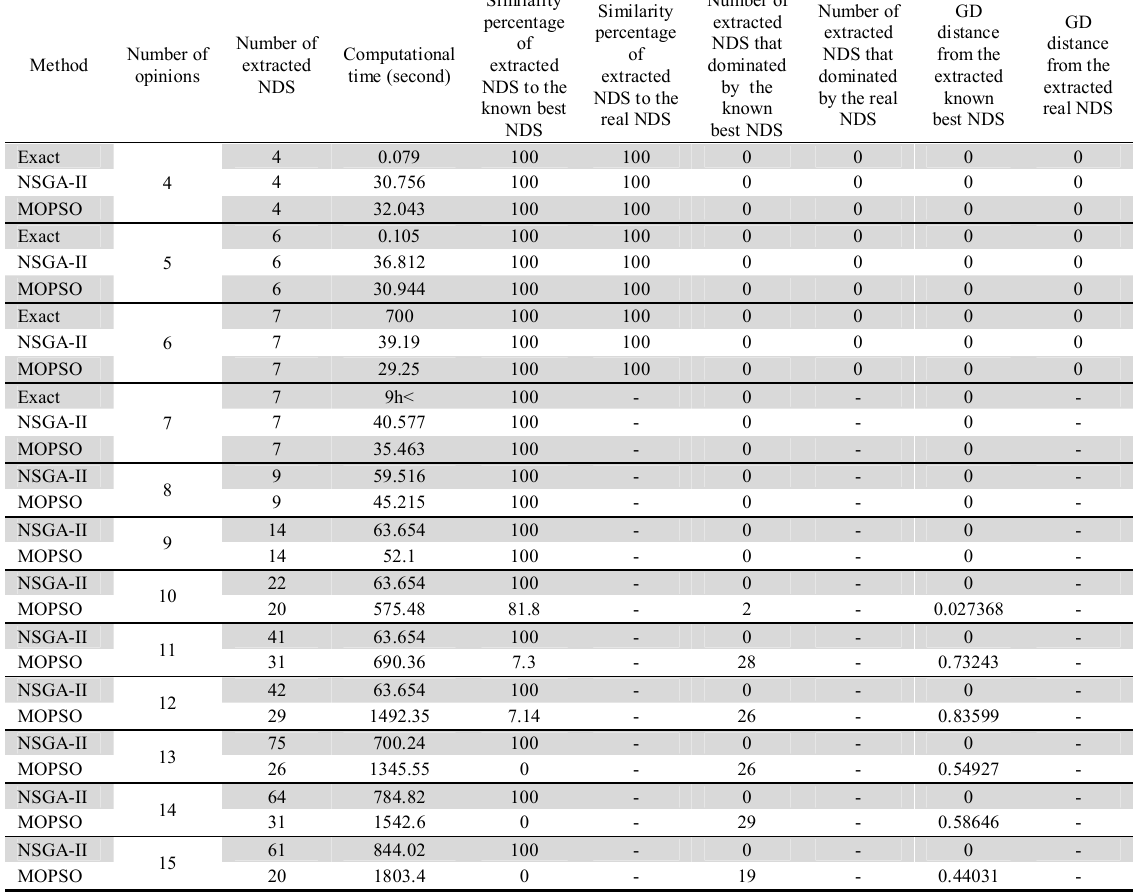
Quality measures of extracted results by three solution approaches for different problem